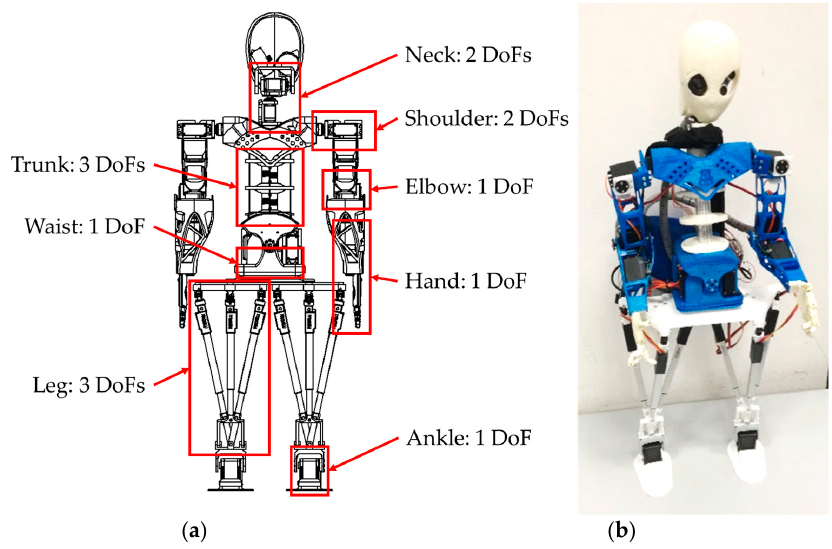
Figure 1. The LARMbot humanoid robot [17,18]: ( a ) Architecture and mobility; ( b ) A prototype. Table 1. Technical specifications of the LARMbot’s torso mechanism (CAUTO) [15,16].